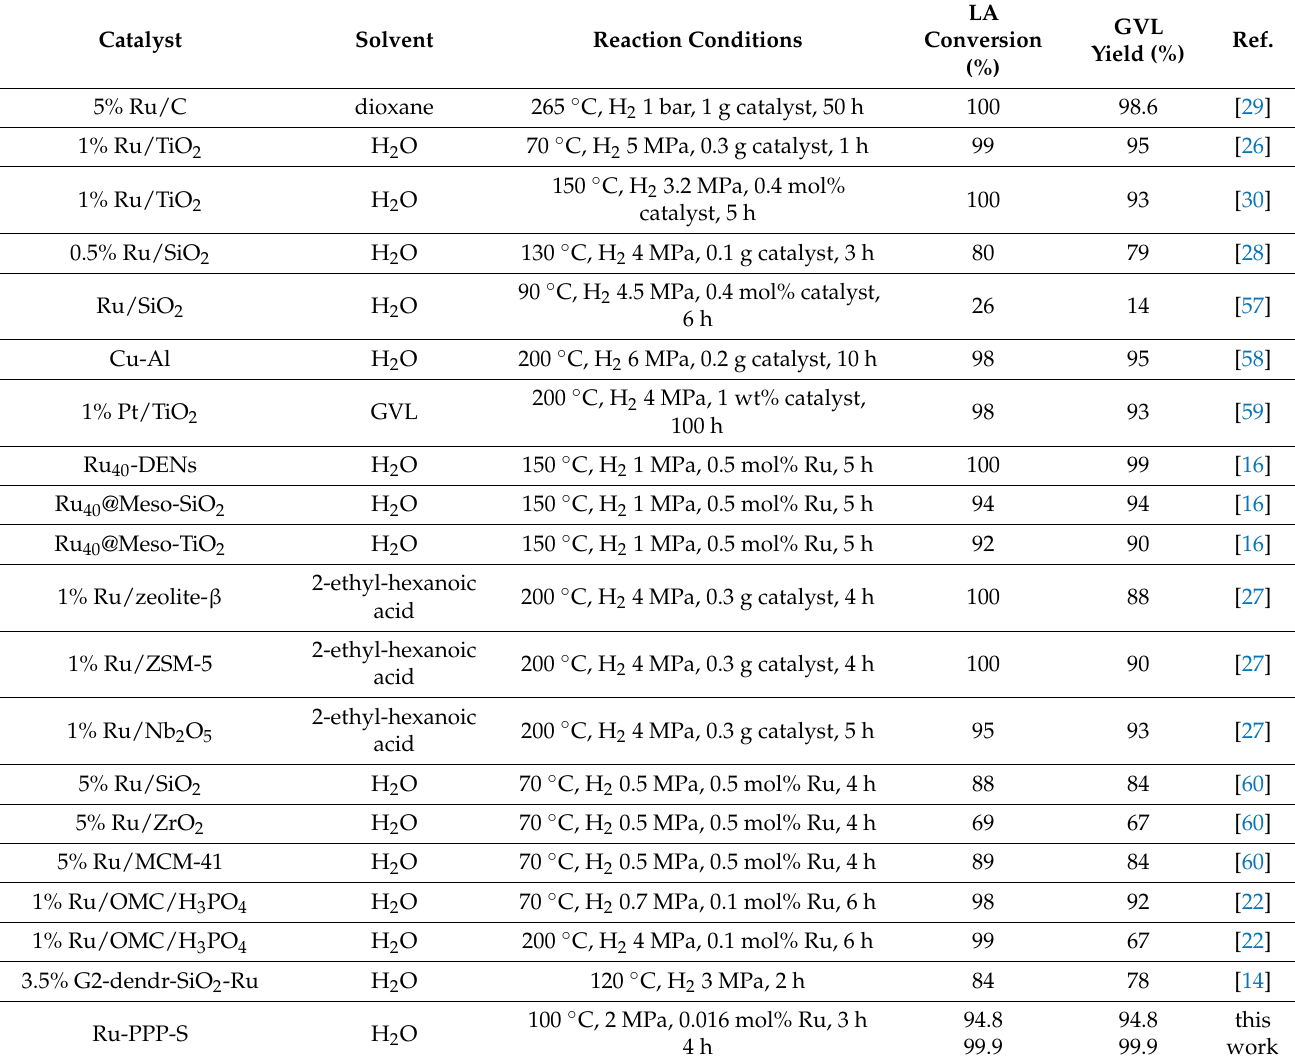
Table 2. Comparison of different heterogeneous catalysts in the LA